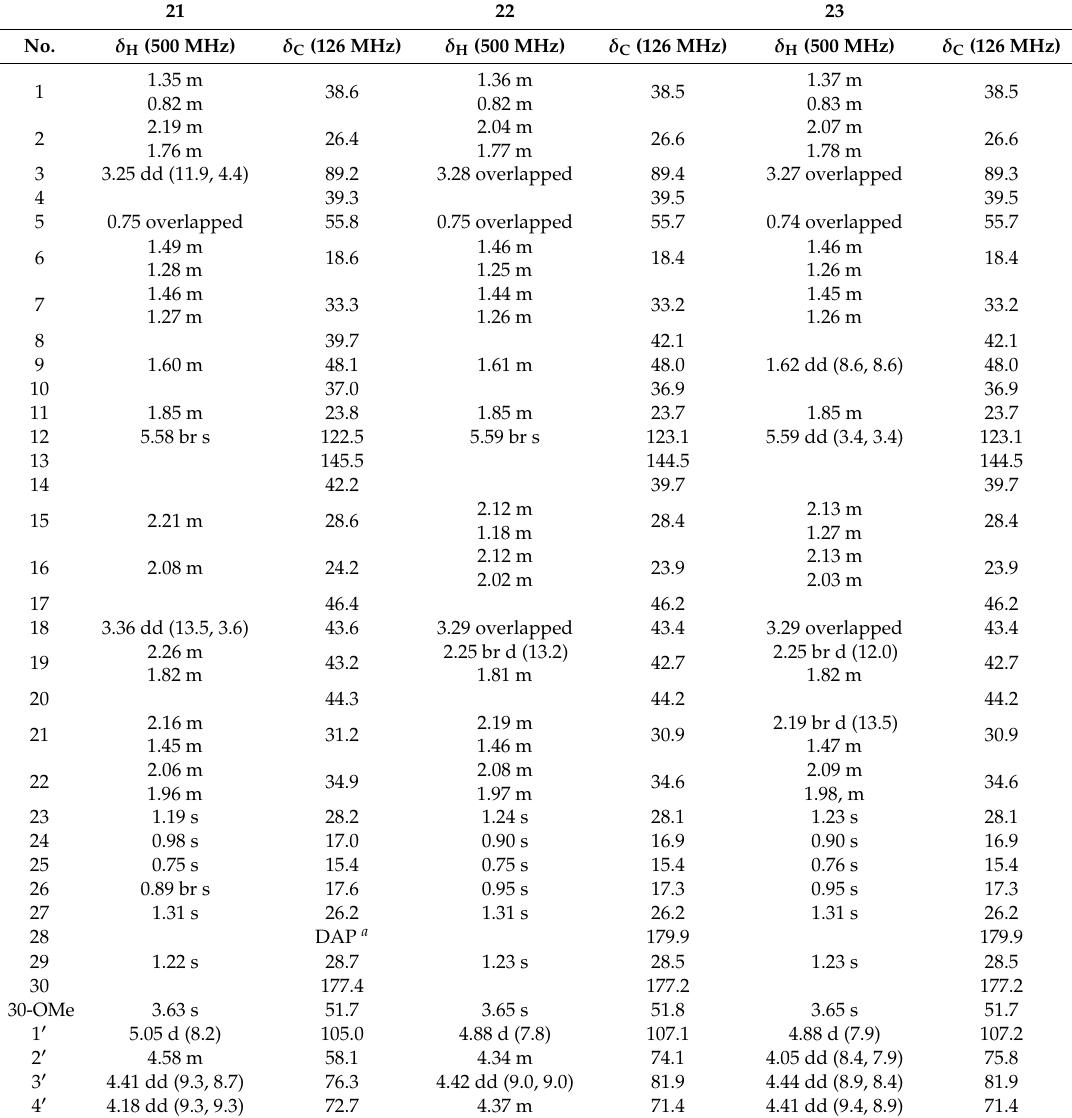
Table 8. 1 H and 13 C-NMR data of 21 – 23 in Pyridine- d 5 ( δ in ppm, J in